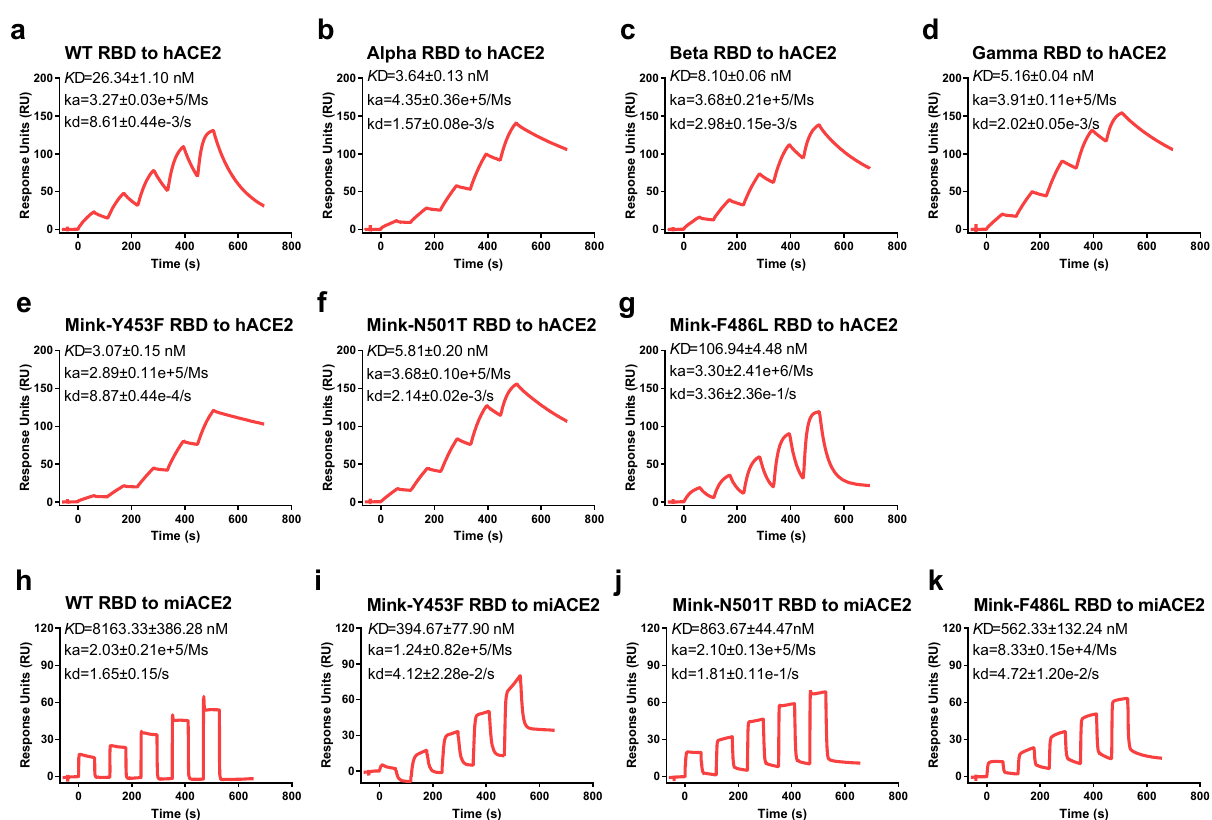
Fig. 2 Binding af fi nity of SARS-CoV-2 RBDs to ACE2, characterized by SPR. a – k Mouse Fc (mFc)-fused hACE2 or miACE2 in the supernatant was captured in the CM5 chip via its interaction with the pre-immobilized anti-mFc antibody. Various concentrations of SARS-CoV-2 WT RBD ( a ), Alpha RBD ( b ), Beta RBD ( c ), Gamma RBD ( d ), Mink-Y453F RBD ( e ), Mink-N501T RBD ( f ), and Mink-F486L RBD ( g ) protein were used to evaluate their binding af fi nity for hACE2. Serially diluted WT RBD ( h ), Mink-Y453F RBD ( i ), Mink-N501T RBD ( j ), and Mink-F486L RBD ( k ) protein were measured the binding to miACE2. K D , ka, and kd values are all recorded and the representative results from three experiments are shown. The data are presented as the mean ± SEM of three independent replicates ( n =